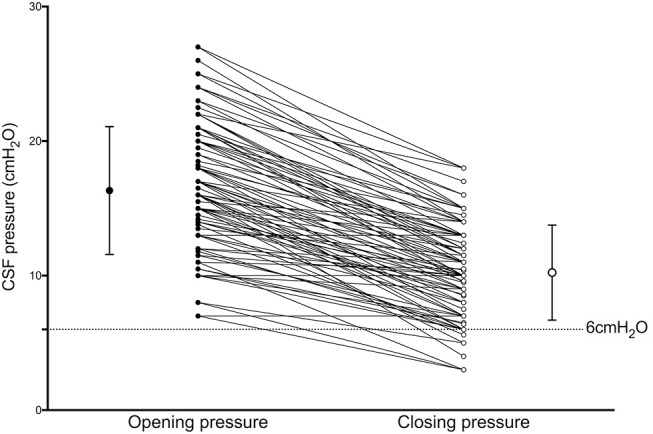
Results of Wilcoxon signed-rank tests between Opening (OP) and Closing (CP) pressure CP is significantly lower than OP (p < 0.001). Bars with whiskers indicate mean with standard deviation of OP (closed dot; 16.3 ± 4.7 cmH2O) and CP (open dot; 10.2 ± 3.5 cmH2O).